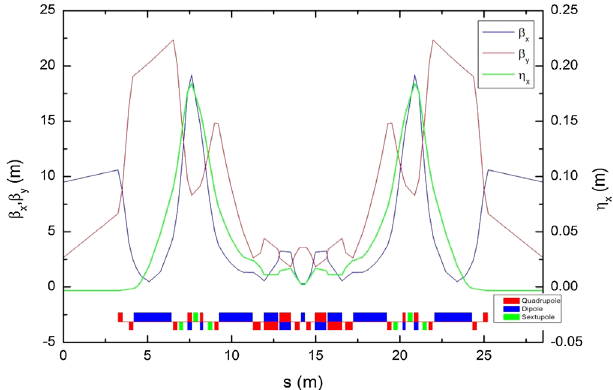
FIG. 3. Pulse shape of normalized cavity power. Red, ideal square input. Black, 100 ns